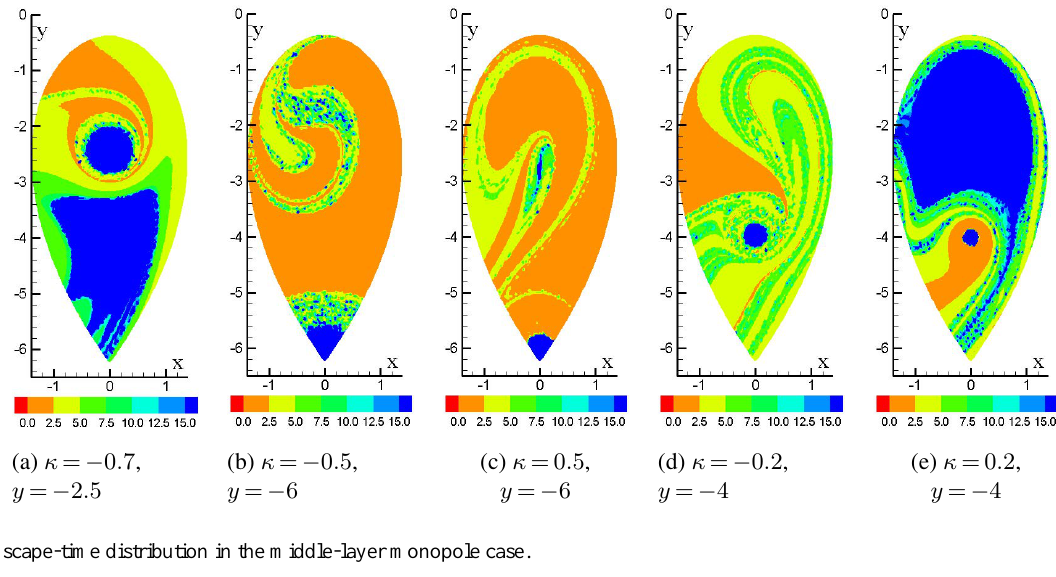
Fig. 10: Escape time distribution in the middle-layer monopole case.